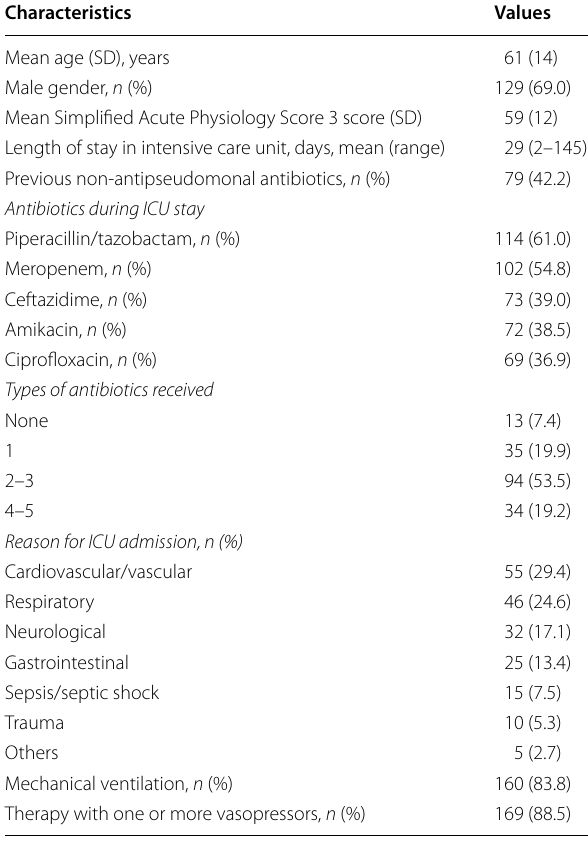
Table 1 Demographic and clinical characteristics of